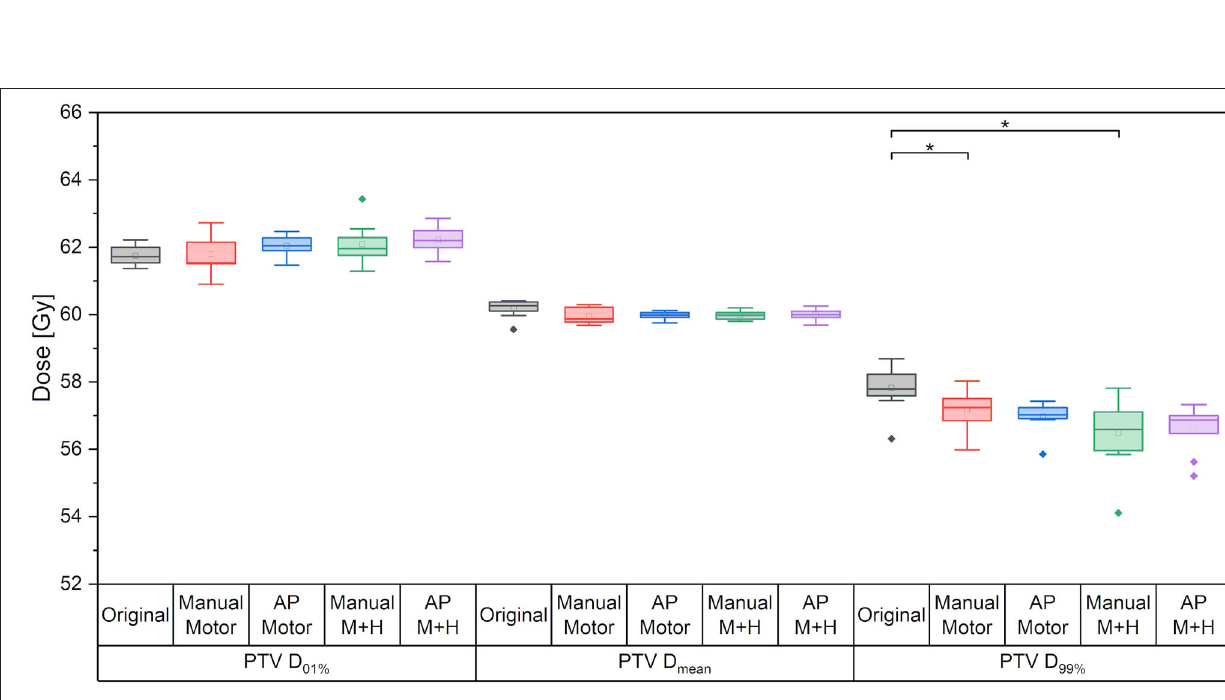
FIGURE 4 | Maximum dose (D 01 % ), mean dose and minimum dose (D99%) to the PTV. Line = median value, square = mean value, diamond = outliers, star = statistically significant at p < 0.005.